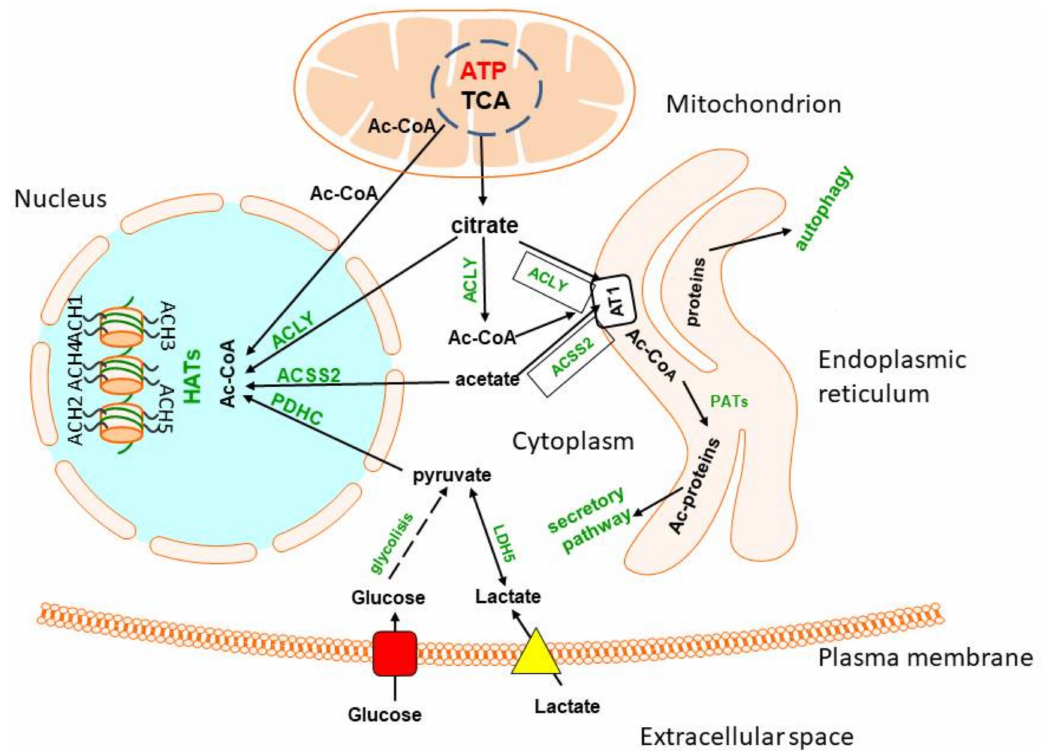
Figure 4. Acetyl-CoA metabolism in endoplasmic reticulum and nucleus. Acetyl-CoA is transported from the cytoplasm to endoplasmic reticulum by the acetyl-CoA transporter 1. It may be taken up directly from cytoplasm or generated by ACLY or ACSS2, forming functional complexes with AT1. Structurally competent proteins are then acetylated in ER lumen by protein acetyltransferases and released by a secretory pathway. Misfolded and damaged proteins are directed to autophagosomes. The nuclear membrane is fully permeable to cytoplasmic acetyl-CoA. However, some amounts of this metabolite are synthesised within the nucleus by ACLY, ACSS2 or PDHC from respective precursor metabolites. They provide acetyl-CoA directly to HATs, which acetylates multiple histones, thereby regulating expression of different parts of the